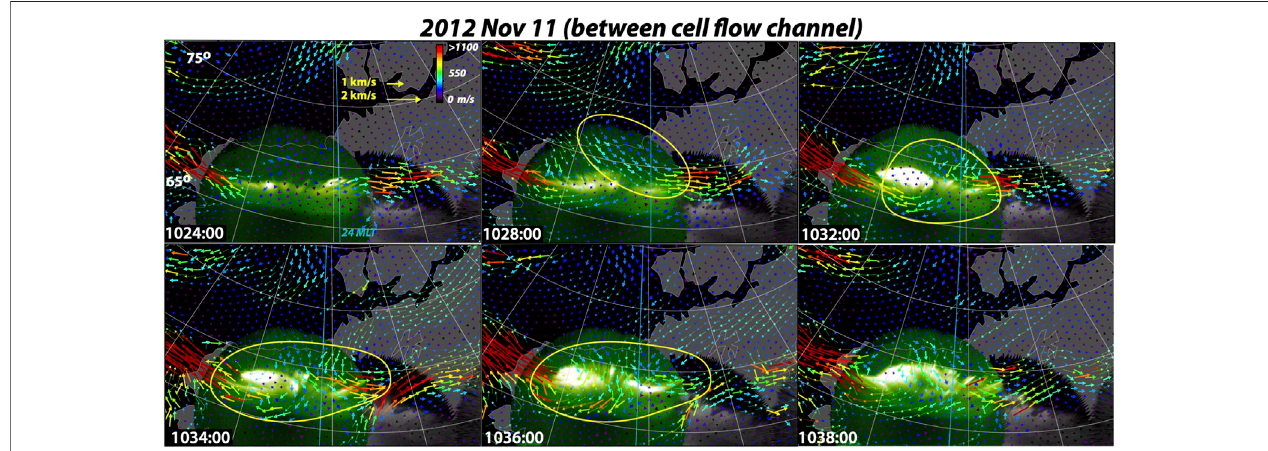
FIGURE 4 | 557.7 nm images from the Poker Flat ASI, with THEMIS ASI image mosaics for the region surrounding the Poker image FOV for a fl ow channel near midnight(cyanline)onNovember11,2012.SuperDARN fl owvectorsareoverlaidontheimagesineachpanel.Vectorsarescaledbothbylengthandbycolor,thefootof the arrow being at the location of the measurement. Heavier fl ow vector arrows are at points with a LOS fl ow measurement. The further from a region of heavier arrows, the more the fl ows shown with the lighter arrows revert to a statistical model. Closed yellow curve approximately encircles the region where fl ows were enhanced relative to that seen at 1024